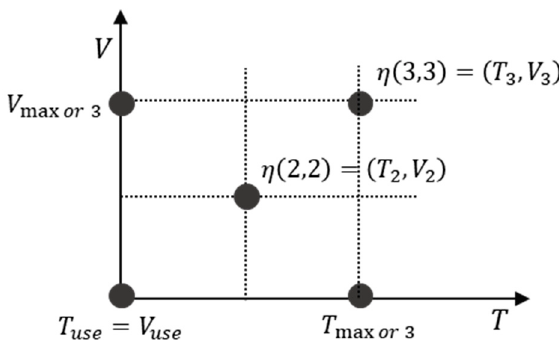
Figure 3. The test points and the individual stress levels in the second phase.